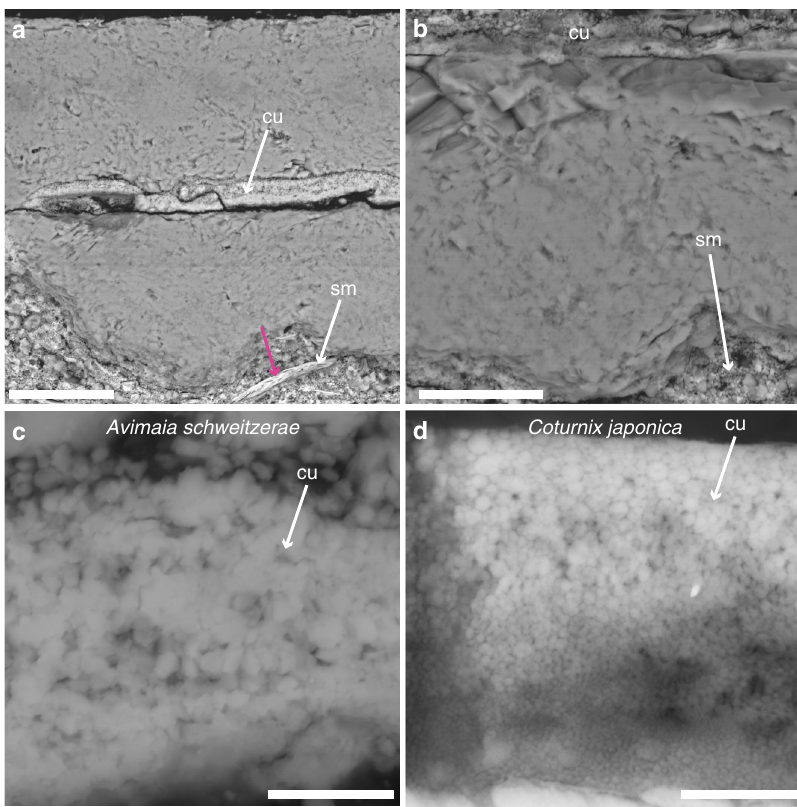
Fig. 3 SEM images showing the cuticle, eggshell, and shell membrane of the egg of Avimaia . Eggshell, cuticle, and shell membrane in cross-section ( a ). One fi bril from the shell membrane is clearly visible (pink arrow). Close-up of the eggshell ( b ) and parts of the overlying cuticle and shell membrane in cross- section ( b ). Close-up of the cuticle of IVPP V25371, showing nanostructures of calcium phosphate ( c ), an adaptation found in modern birds, such as the Japanese quail, Coturnix japonica ( d ), to protect the embryo in infection-prone environments. It also represents the hypothesized ancestral morphological condition for avian cuticles. Abbreviations: same as Fig. 2. Scale bar is 50 μ m in a , 20 μ m in b , 3 μ m in c , and 2 μ m in